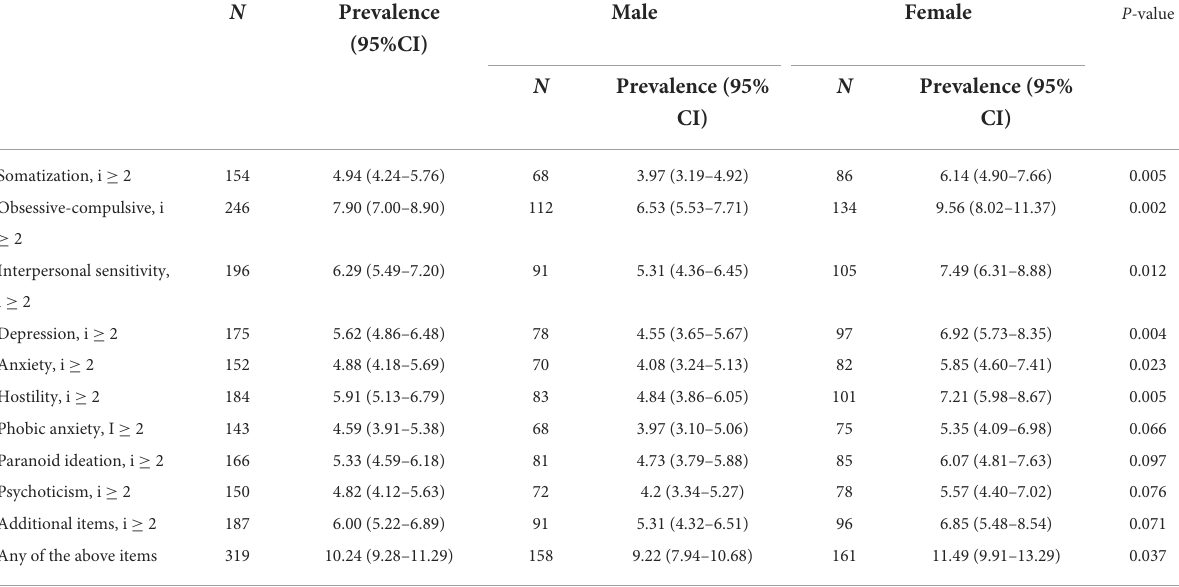
TABLE 3 Prevalence of self-reported psychological symptoms and stratified by gender * .